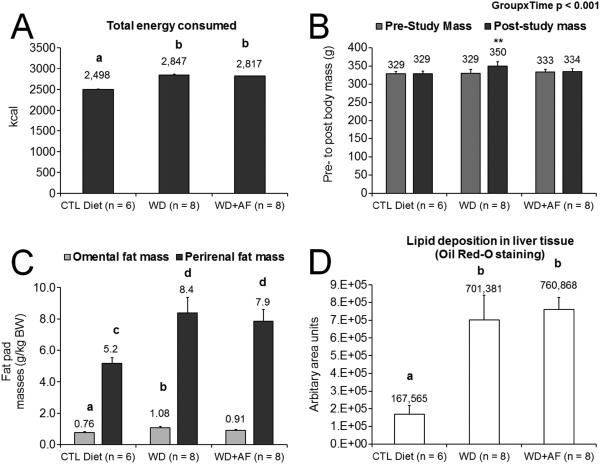
Between-treatment phenotypes during and following the feeding intervention. WD and WD + AF similarly increased Caloric intake compared to CTL rats (A). WD rats experienced an increase in body mass pre- to post- intervention (B), although omental fat pad masses, perirenal fat pad masses and liver fat deposition assessed during necropsies were not different between treatments (C/D). Abbreviations and symbols: CTL = control low-fat/low-sugar 14% diet, WD = Western diet, WD + AF = Western diet + anti-inflammatory supplement; different superscript letters represents differences between groups (p < 0.05); In A, different superscript letters represents differences between groups (b > a, p < 0.05); In B, **represents a significant pre- to post-change in body mass within groups (p < 0.01); In C, different superscript letters represents differences between groups (for omental fat mass b > a, p < 0.05; for perirenal fat mass d > c); In D, different superscript letters represents differences between groups (b > a, p < 0.05).